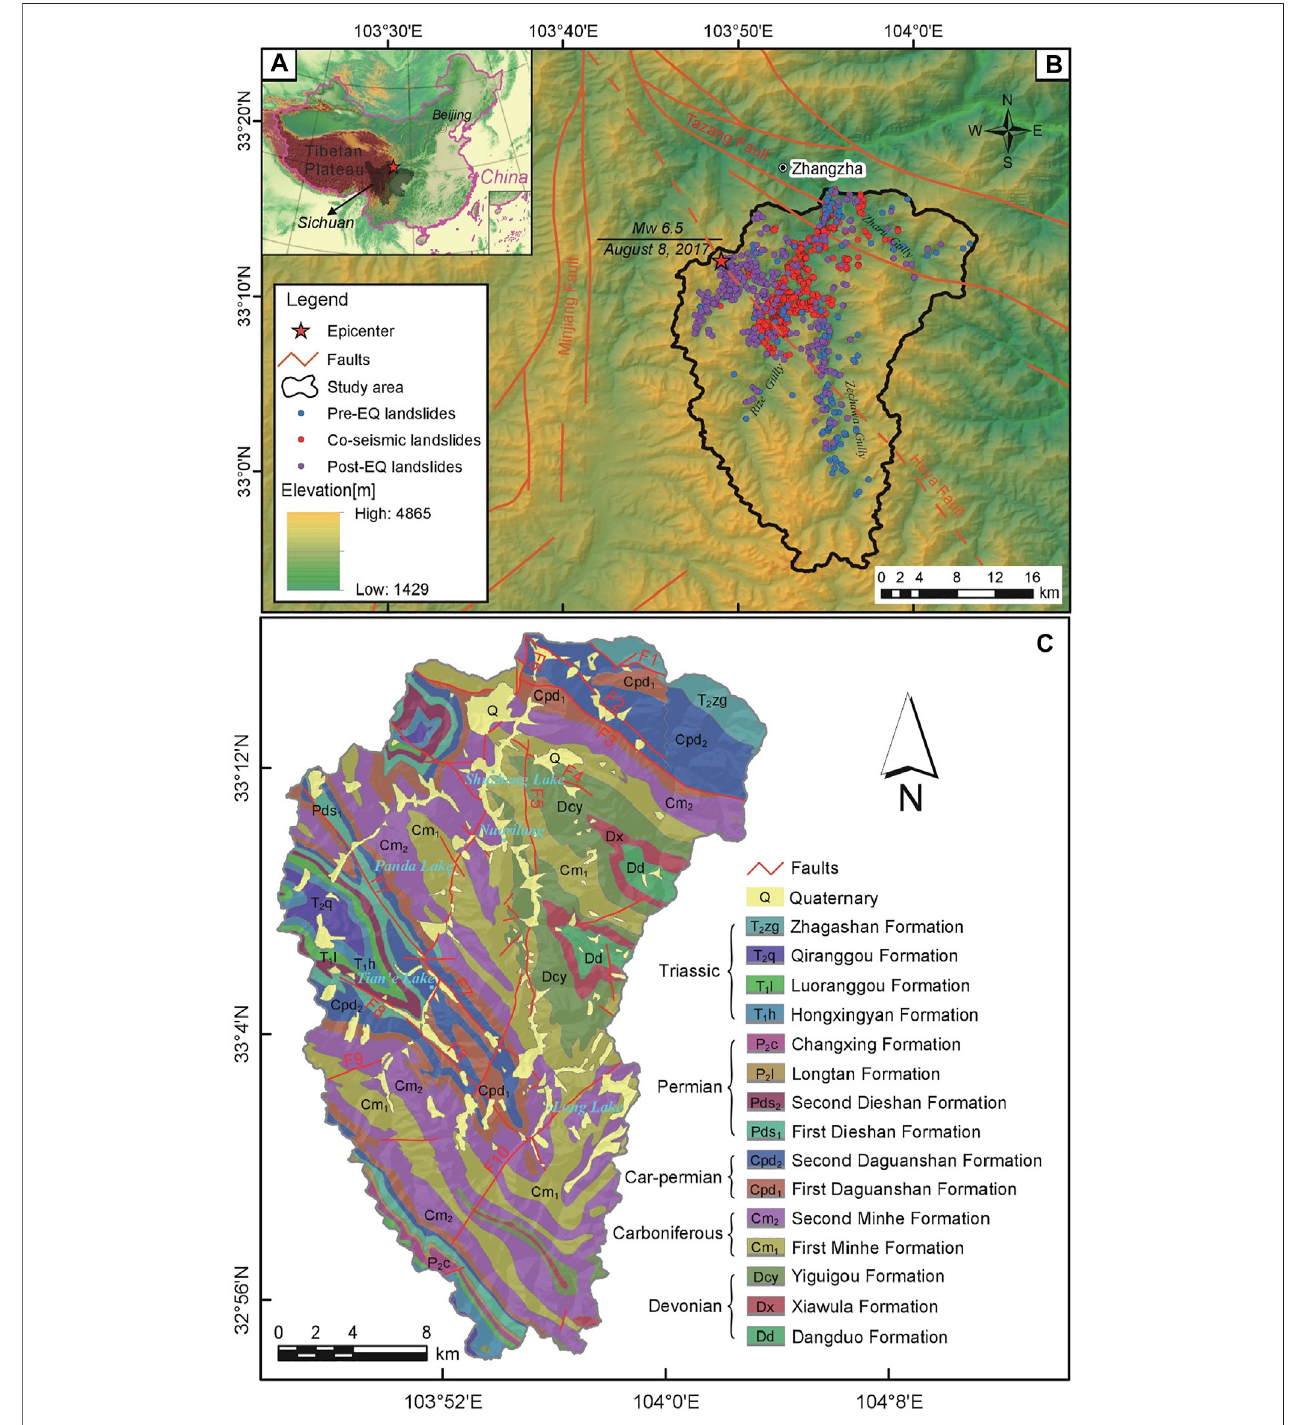
FIGURE 1 | (A) Geographical location map of the study area in southwestern China; (B) Regional tectonic setting, epicenter, and distribution of multi-temporal landslide identi fi cation points (LIPs) within the Jiuzhaigou National Geopark. EQ stands for the 2017 M w 6.5 Jiuzhaigou earthquake; (C) Geologic map showing the outcroppinglithologyandfaultlinesofthestudyarea.F1:ErgenFault,F2:ZharugouFault,F3:HeyeFault,F4:LuweihaiFault,F5:ZechawaFault,F6:JiuzhaigouFault,F7: Yingzhuadong Fault, F8: Xuanquan Fault, F9: Loubangou Fault, and F10: Changhai Fault.